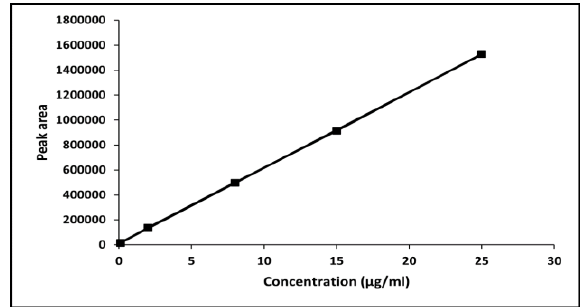
Fig. 3 . Calibration curve for determination of HEX in pure form at λ max = 265 nm using the proposed method.